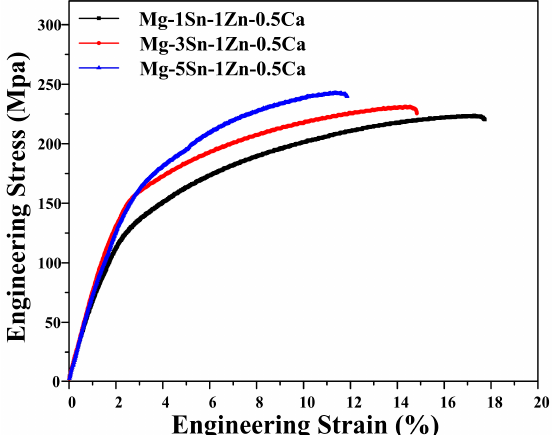
Figure 5. Tensile engineering stress-strain curves of hot-rolled Mg–xSn–1Zn–0.5Ca (x = 1, 3 and 5 wt.%) alloys. Table 3. Tensile properties of the hot-rolled Mg–xSn–1Zn–0.5Ca (x = 1, 3 and 5 wt.%) alloys investigated. Alloy